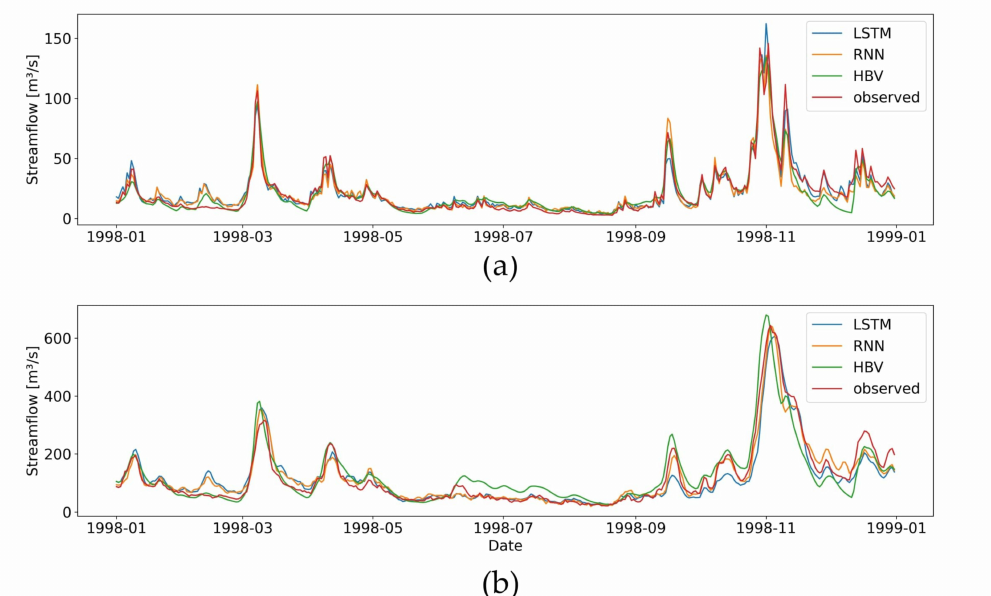
Figure 5. Hydrographs of all models and observed streamflow within sub-catchment 1 ( a ) and sub-catchment 5 ( b ) in the year 1998 to show annual variations in streamflow and the models’ performances